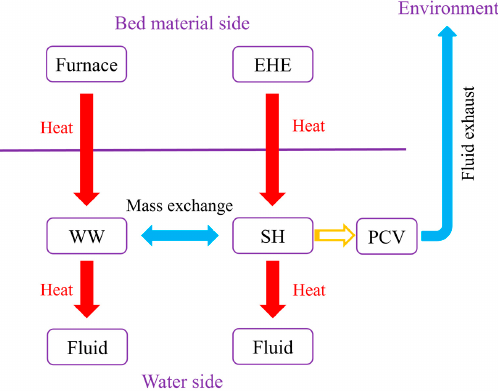
Figure 3. Schematic of interactions between different